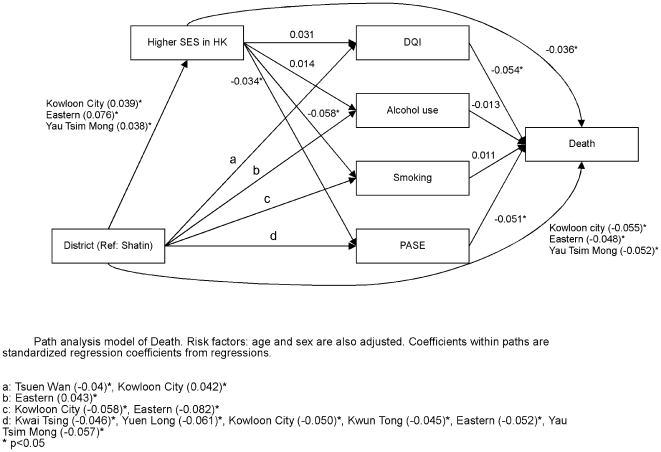
Path analysis model of Death.